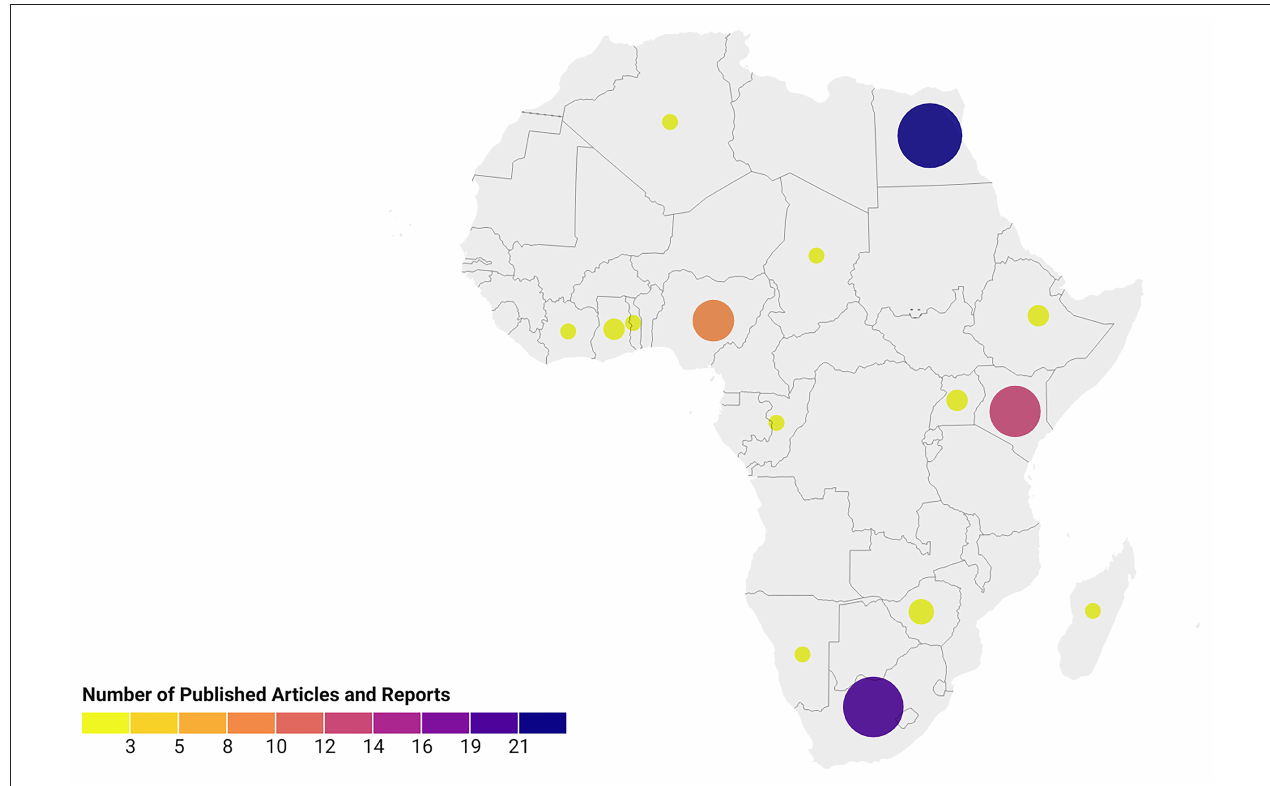
FIGURE 1 | Bubble plot showing the number of aquaponic publications in different African countries (bubble color and size indicate the number of studies in each highlighted